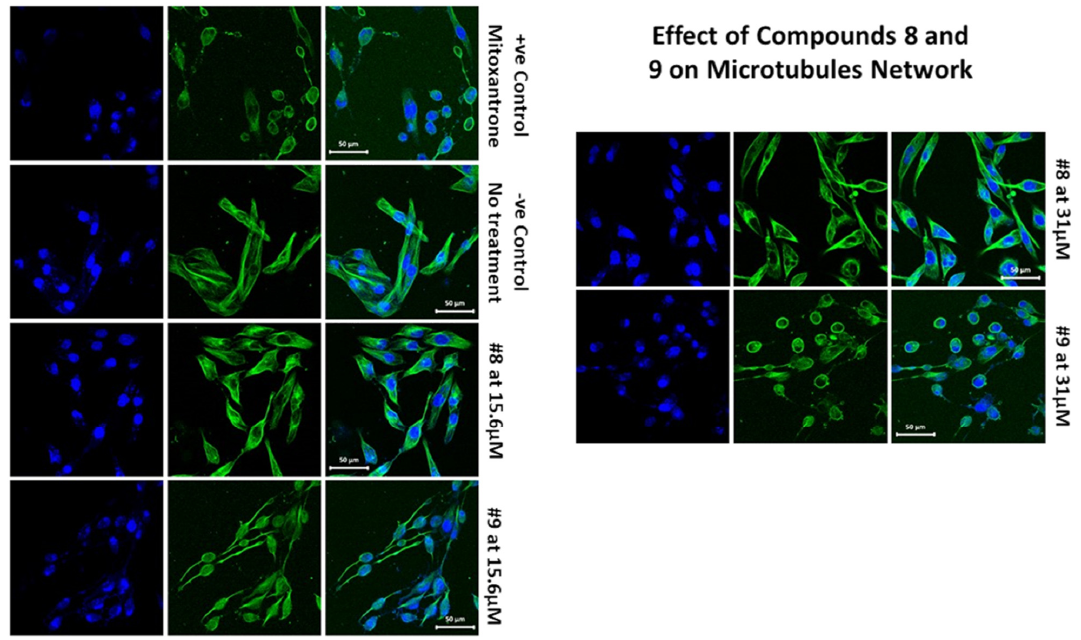
Figure 6. Effects of compounds 8 and 9 on the microtubular network.